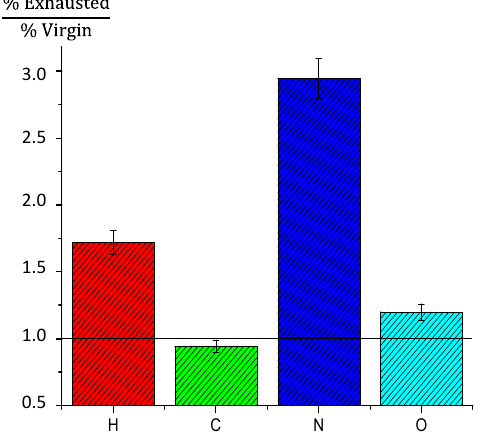
Figure 6. CHNS ‐ O elemental analysis data for “virgin” GAC ‐ 1 and “exhausted” GAC ‐ 5 expressed Figure 6. CHNS-O elemental analysis data for “virgin” GAC-1 and “exhausted” GAC-5 expressed as as the element ratio. the element